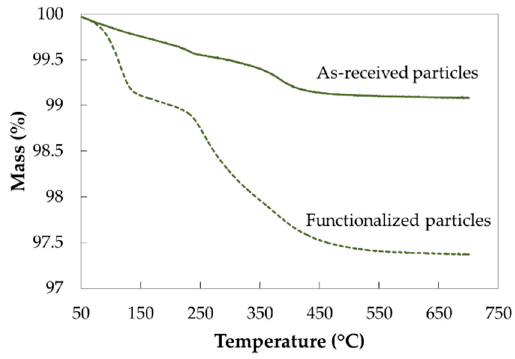
Figure 2. Mass (%) as a function of temperature of the as-received (solid line) and the functionalized (dotted line) alumina particles.